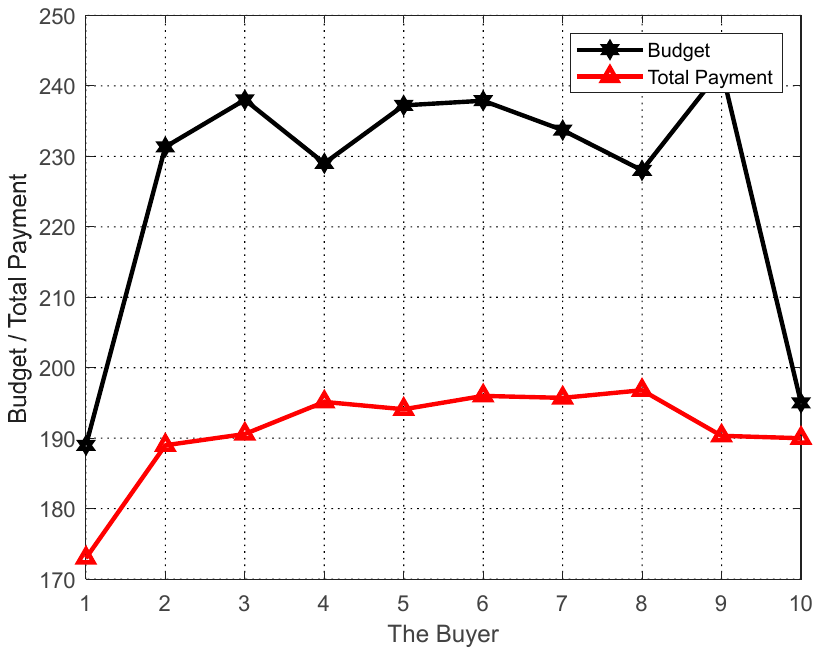
Figure 3. Individual analysis of the task.